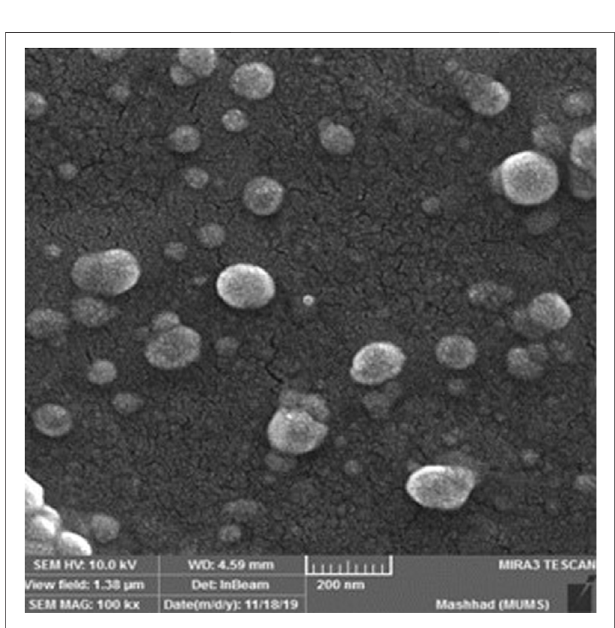
Frontiers in Molecular Biosciences |